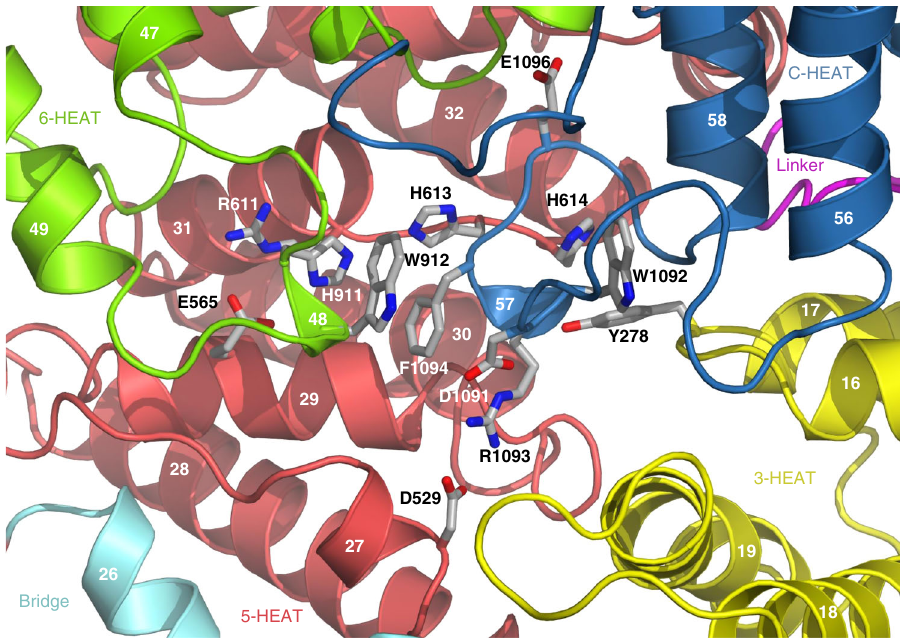
Fig. 4 Interface between 3-HEAT, 5-HEAT, 6-HEAT, and C-HEAT domains. Structural illustration showing the molecular environment at the interface between 3-HEAT, 5-HEAT, 6-HEAT, and C-HEAT on the convex face of core MED23. R611 (corresponding to R617 in isoform 2, NM_015979.2) forms a buried salt bridge with E565 and is stacked against an aromatic cluster surrounding structural elements strictly conserved in all metazoans, at the center of the